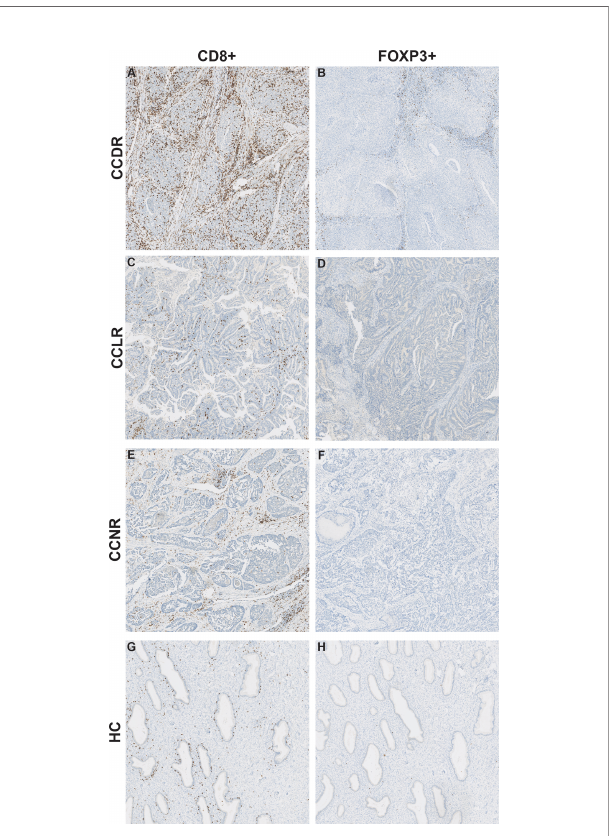
FIGURE 5 | CD8+ cells andFOXP3+ cells in cervicalcancer tissue. Representativeimages for immunohistochemical staining of CD8and FOXP3 in cervical cancer tissue. The CD8and FOXP3 images are from the same patient for each cervicalcancer group. (A) CD8+ cellsinCCDR. (B) FOXP3+ cells inCCDR. (C) CD8+ cellsinCCLR. (D) FOXP3+ cells inCCLR. (E) CD8+ cells in CCNR. (F) FOXP3+ cells inCCNR. (G) CD8+ cellsinHC. (H) FOXP3+ cells in HC.